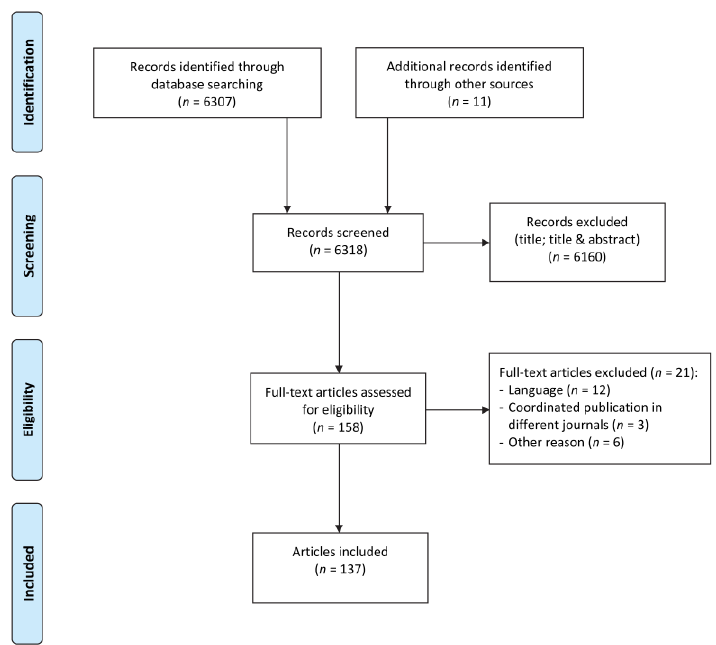
Figure 1. Flow diagram from identified to included reports or studies. Table 1. Description of the typology of 137 included articles.